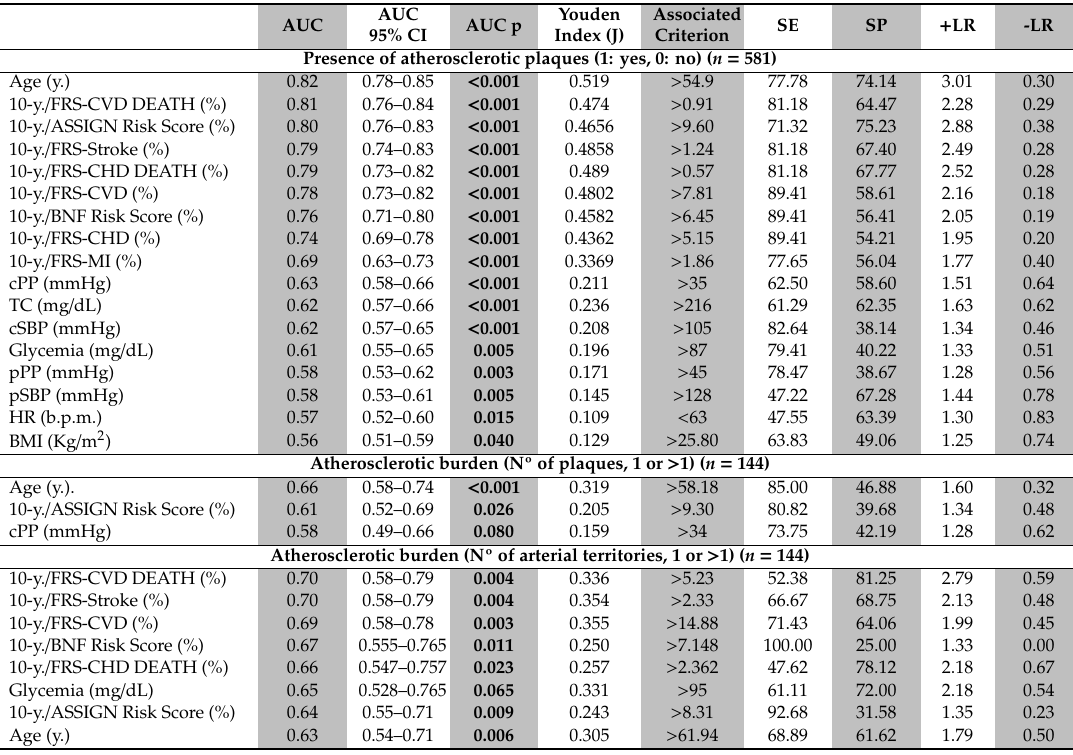
Table 4. Atherosclerotic plaques presence or burden: ROC curves-derived parameters.